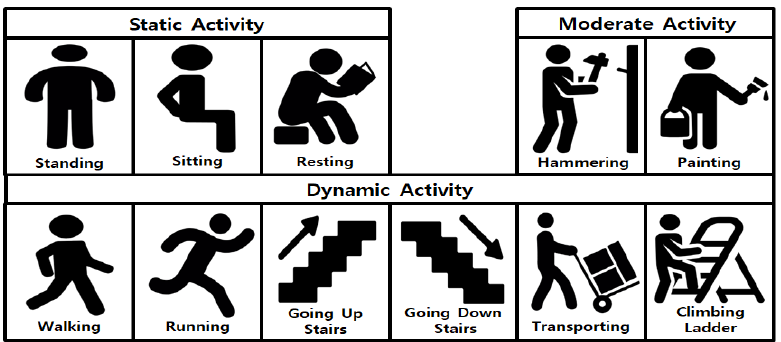
Figure 12. Classification of static, moderate, and dynamic activities of workers in test